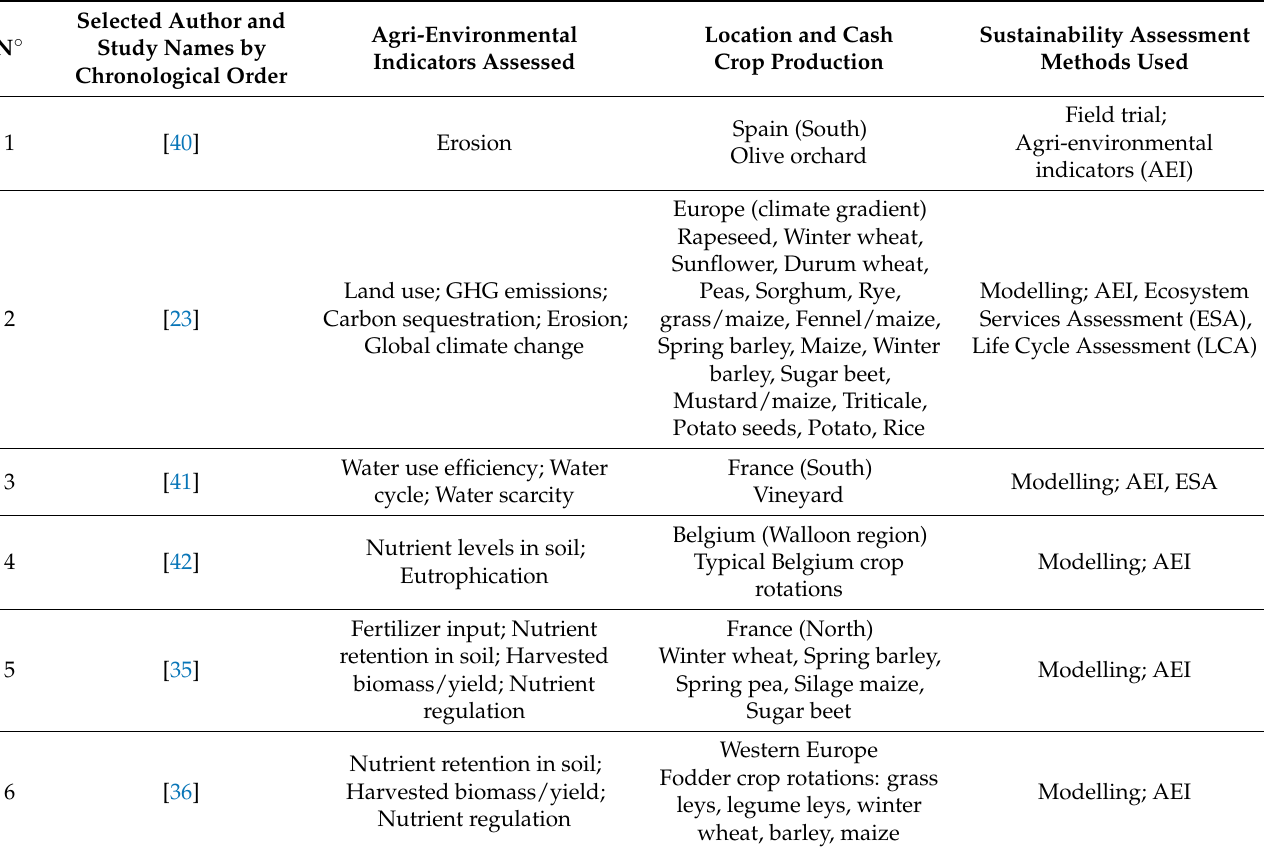
Table A1. Selected studies from the systematic literature review of the cover crops case